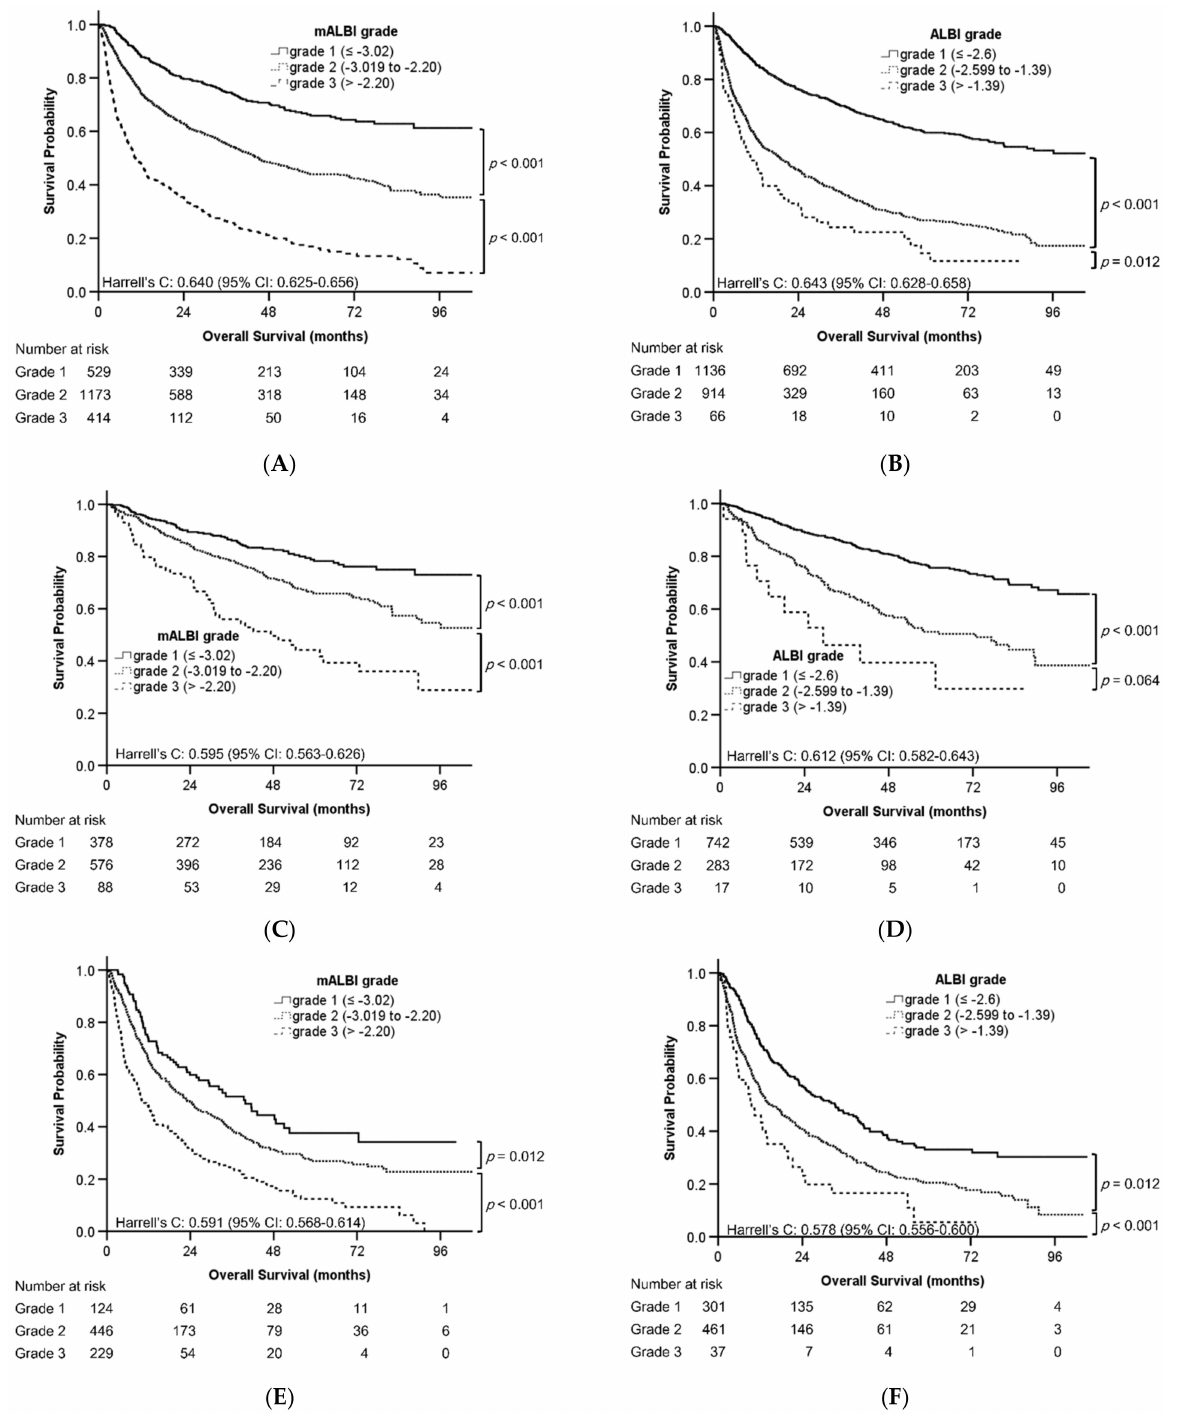
Figure 2. Kaplan–Meier analyses of the overall survival. ( A ) mALBI grade of all patients. ( B ) Original ALBI grade of all patients. ( C ) mALBI grade of patients receiving curative therapy. ( D ) Original ALBI grade of patients receiving curative therapy. ( E ) mALBI grade of patients receiving TACE. ( F ) Original ALBI grade of patients receiving TACE. ALBI, albumin–bilirubin; CI, confidence interval; mALBI, modified ALBI; TACE, transarterial